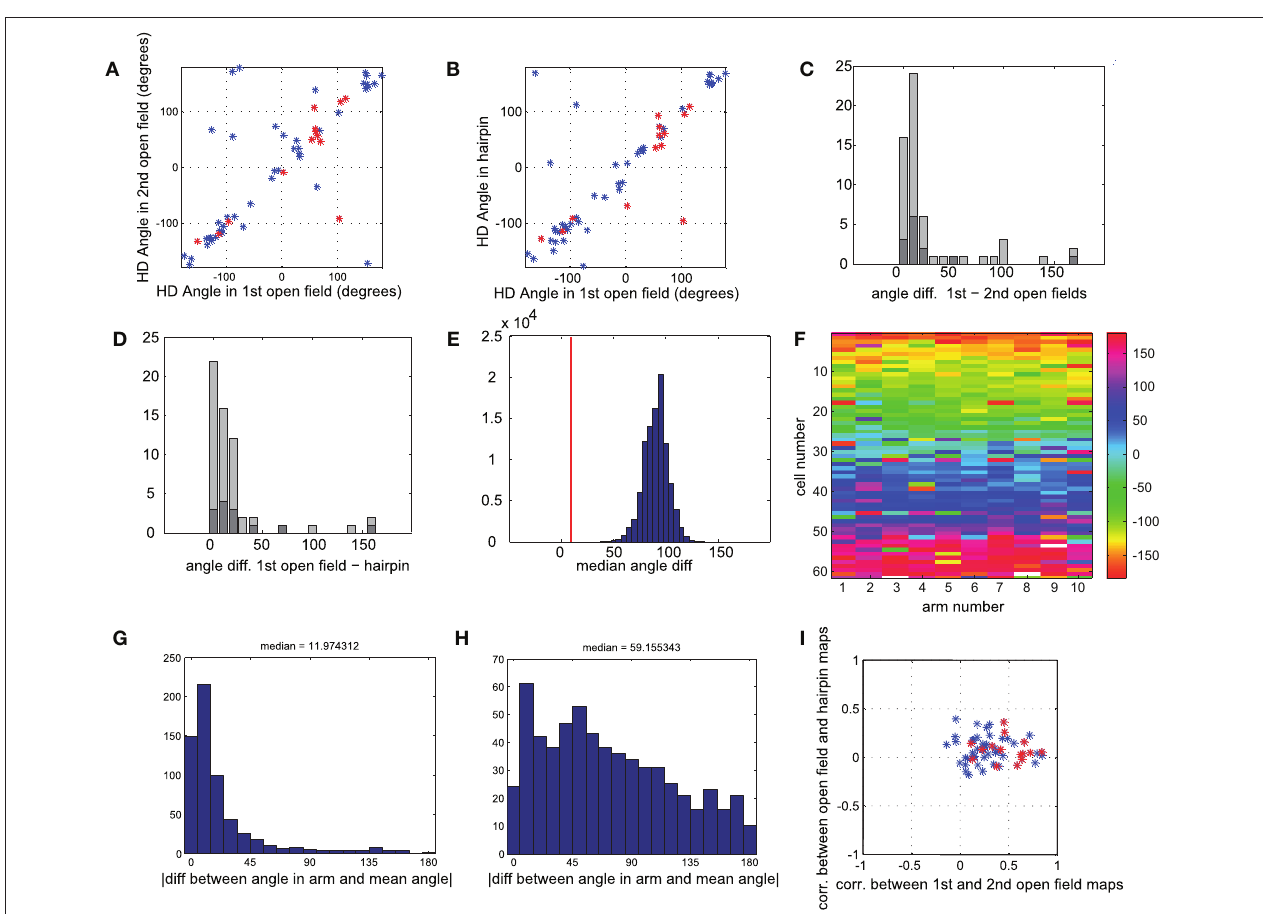
FIGURE 4 | Head direction is similar for all conditions. (A) Head direction angle preference for each cell, calculated from the direction of the Rayleigh vector, in the first vs. second open-field conditions. Red points mark sub-populations of conjunctive grid × head direction cells (gridness > 0.5 in open-fields). (B) Head direction angle preference in first open-field vs. hairpin maze. Red points as in A. (C) Histogram of absolute angle differences between head direction preferences in first and second open-field conditions. Dark gray bars mark conjunctive cells. Absolute angle difference can range between 0 ◦ and 180 ◦ , with an expected median of 90 ◦ , as can be seen in shuffled data (panel E ). (D) Histogram of absolute angle differences between head direction preferences in first open-field condition vs. hairpin condition. Dark gray bars mark cells with high grid scores. (E) Real value of median angle difference between head direction in open-field vs. hairpin maze (shown in E ) was 8.8 ◦ , lower than 100,000 monte-carlo angle differences generated from shuffled data. (F) Color-coded matrix of head direction preferences of each cell in each arm of the